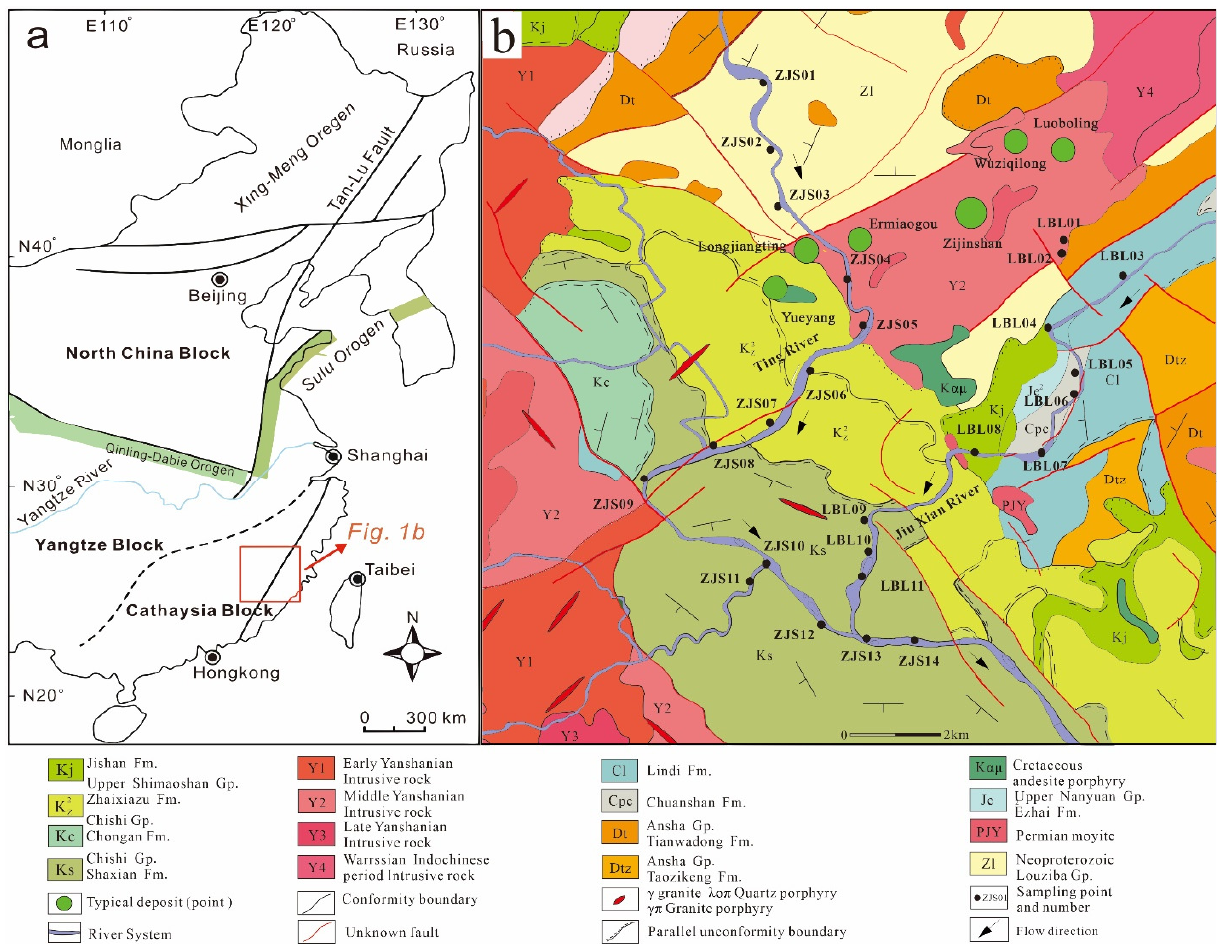
Figure 1. ( a ) Simplified geological map of eastern South China (modified after Zhao et al. [33]). ( b ) Sampling sites of stream sediments and geological map of the Zijinshan Copper-Gold Orefield (modified from 1:200,000 geological map of Fujian Province, China).